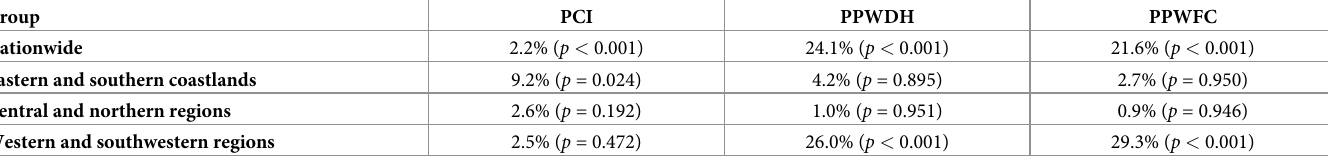
Table 3. GeoDetector q -statistic value (F test value) for the influencing power of a single factor at the county level in China’s eastern and southern coastlands, cen- tral and northern regions, and western and southwestern regions. Group